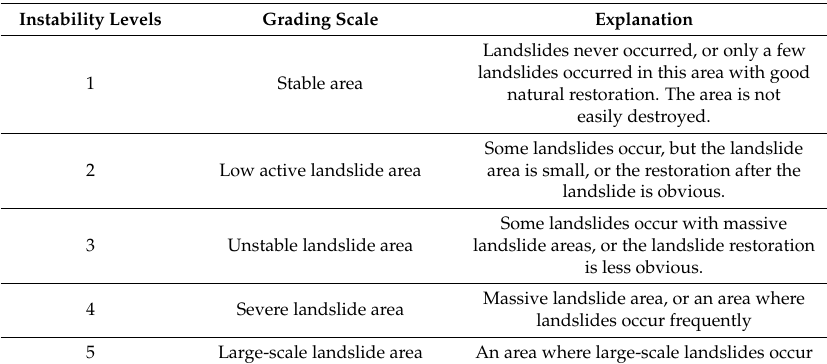
Table 2. Grading scale chart for instability levels.